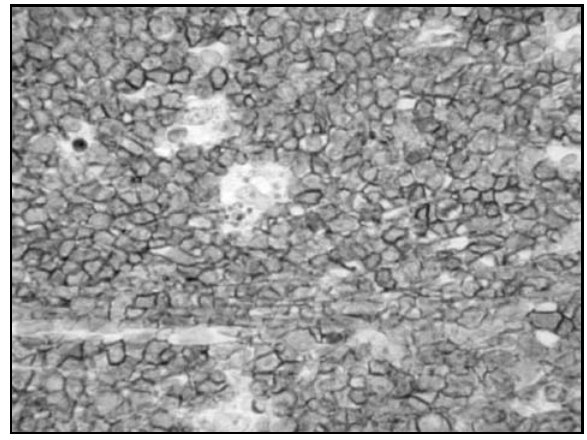
Figura 4 (caso 1) – Imunorreatividade nas membranas celulares de células neoplá- sicas para CD3 (400x)